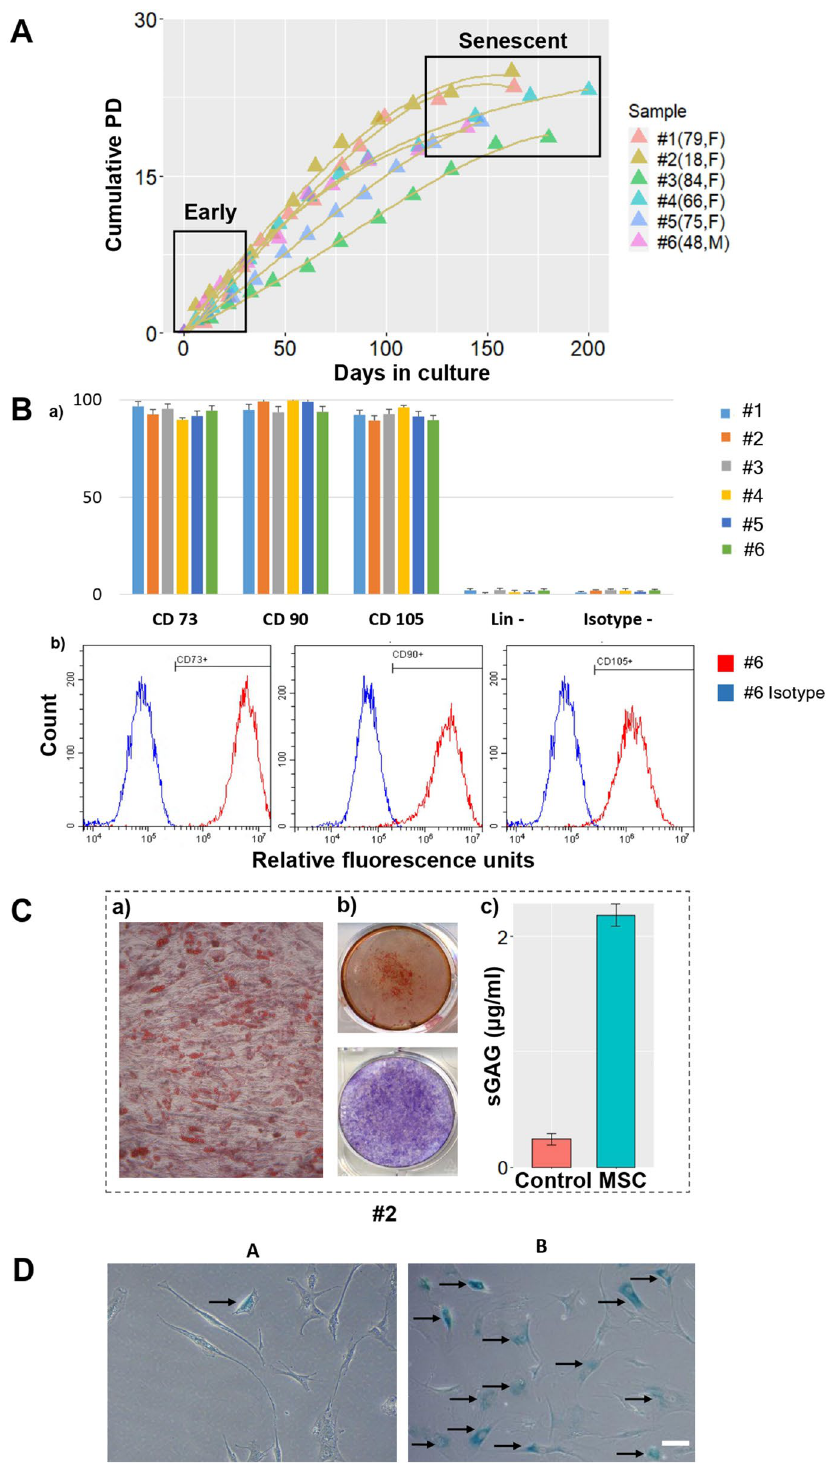
Figure 2. Characterisation of hMSCs used in this study. ( A ) Cumulative population doubling of the six selected donor samples (biological repeats n = 6) collected through in vitro expansion over a period of 7 months. Early passage cells are defined when their cumulative PD value is closest to six and senescent passage cells are defined as cells failed to double in 2 weeks’ time. ( B ): (a) Combined data on ISCT phenotypic characterization of all six donor MSC samples on CD73, CD90, CD105, Lin-: lineage negative, Isotype-: isotype control antibodies. Bars represent mean values and error bars represent standard deviations (SDs) (b) Representative histograms for donor #6 on CD73, CD90 and CD105 characterization. ( C ) Representative hMSCs differentiation results (donor #2) from left to right: (a) Oil Red O stained lipid vesicles after adipogenesis (b) Alizarin red staining demonstrating calcium deposition (middle upper) and alkaline phosphatase (middle lower) both indicating osteogenic differentiation (c) hMSCs chondrogenesis with sGAG levels higher than a control sample of hMSCs not cultured in chongrogenic media. ( D ) β -galactosidase staining images of early ( A ) and senescent passages ( B ) of a selected donor sample. At least 200 cells were measured and counted per β -galactosidase staining m experiment. Arrows indicate β -galactosidase positive hMSCs. Scale bar indicates 50 µ